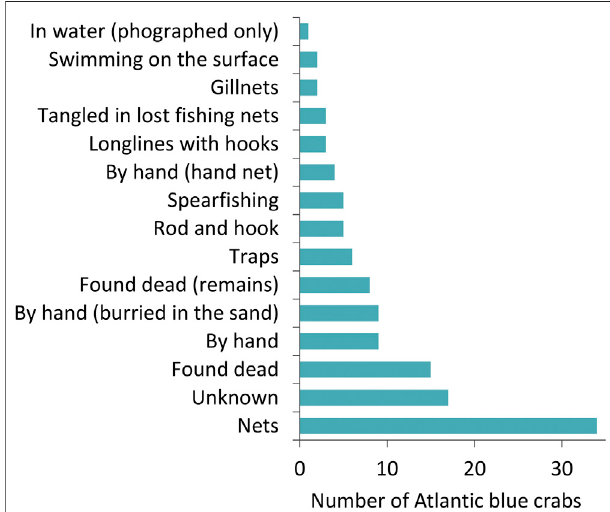
FIGURE4| Typeofobservationormethodofcapturereportedbycitizen scientists to NEMA about the Atlantic blue crab between April 2019 and the end of March